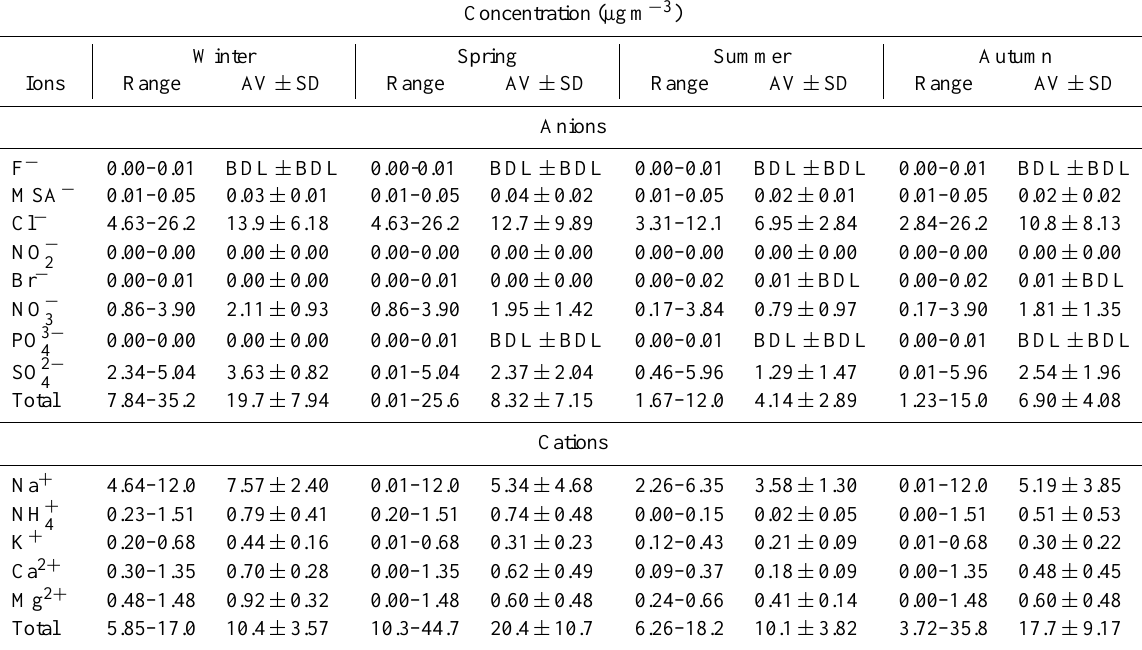
Table 2. Seasonal variations of ionic species in aerosols from Cape Hedo,